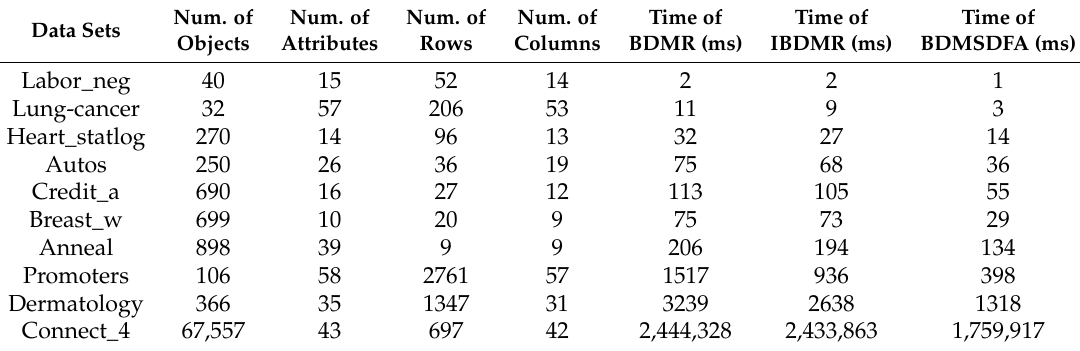
Table 2. Time consumption of BDMR, IBDMR and